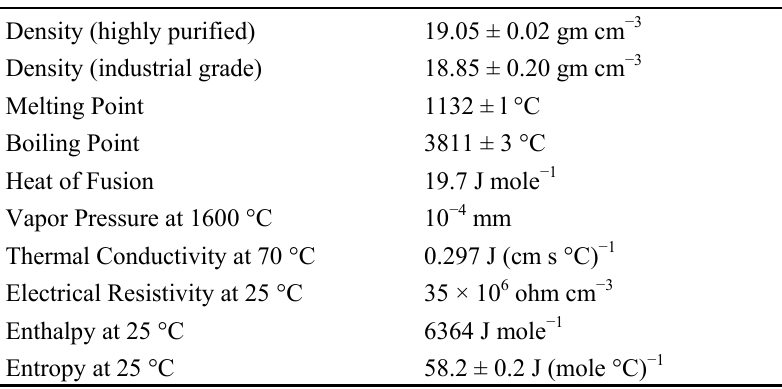
Table 4. Physical properties of uranium